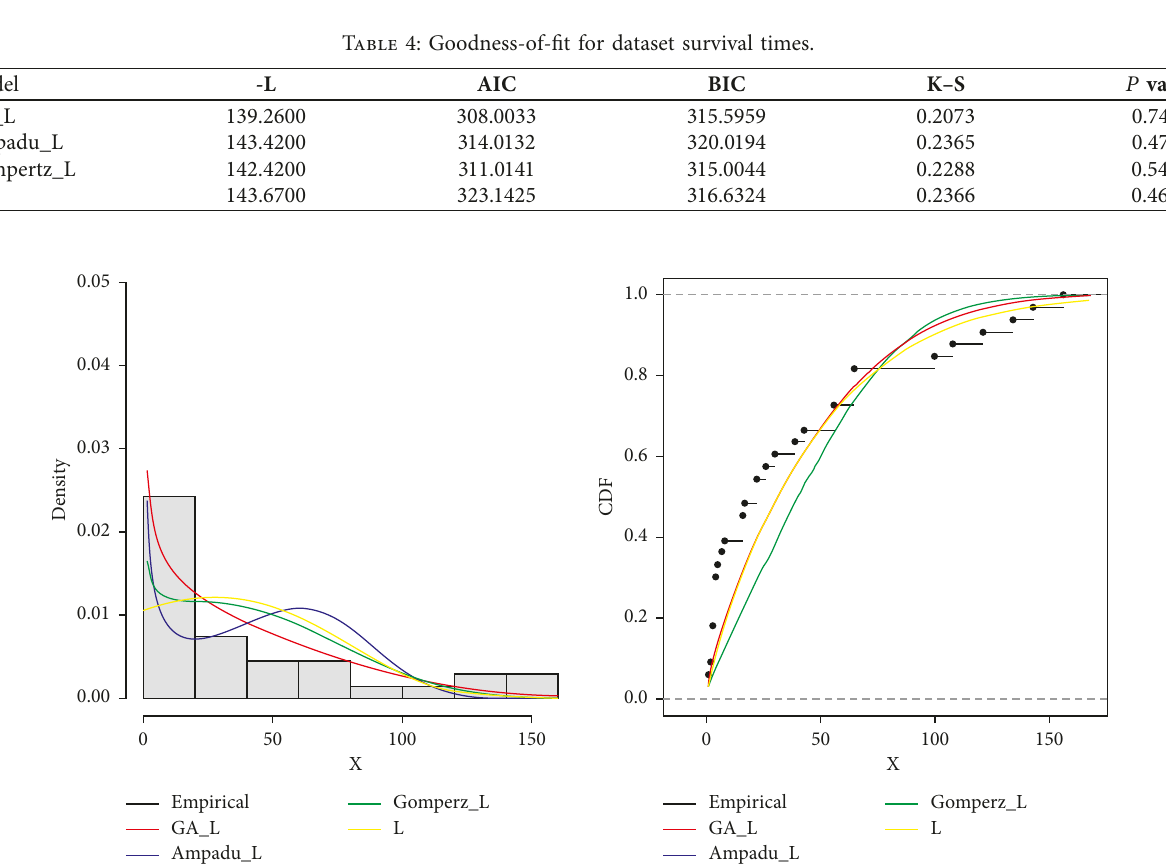
Figure 3: Histogram plot of models with survival times